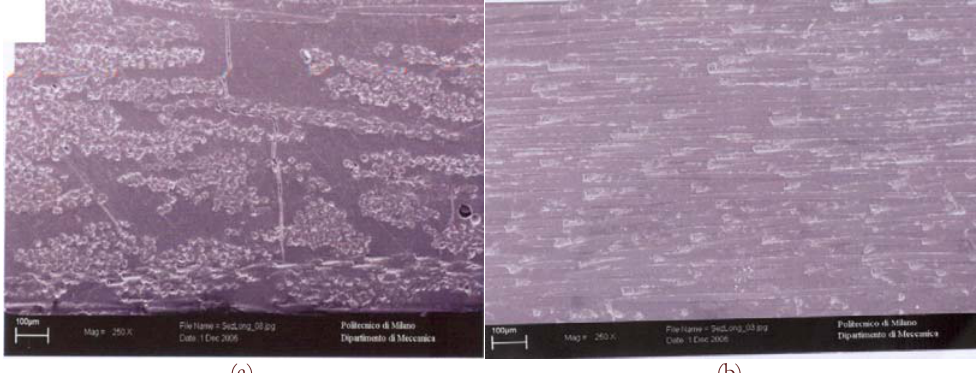
Figure 10: SEM images of the fatigue specimens: (a) Mat, (b) Roving.